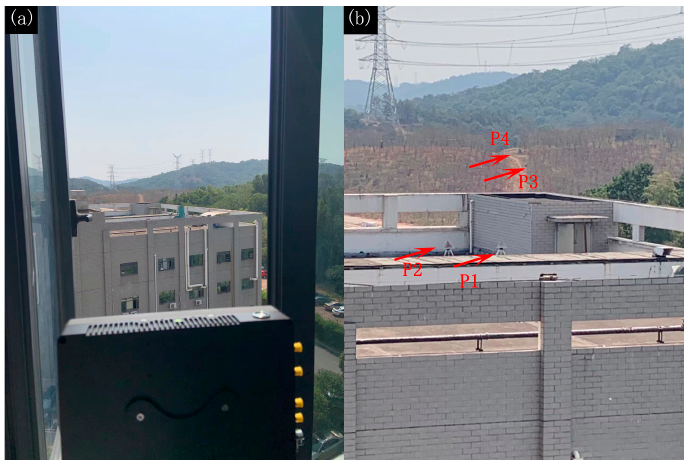
Figure 3. The spatial location of the four reflectors. ( a ) the overall observation view, ( b ) the position of the four reflectors.